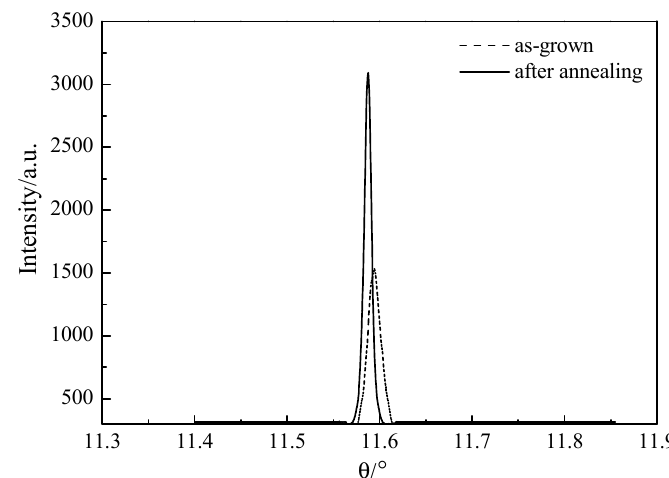
Figure 5. X-ray rocking curves of CMT:In slices, before and after annealing.